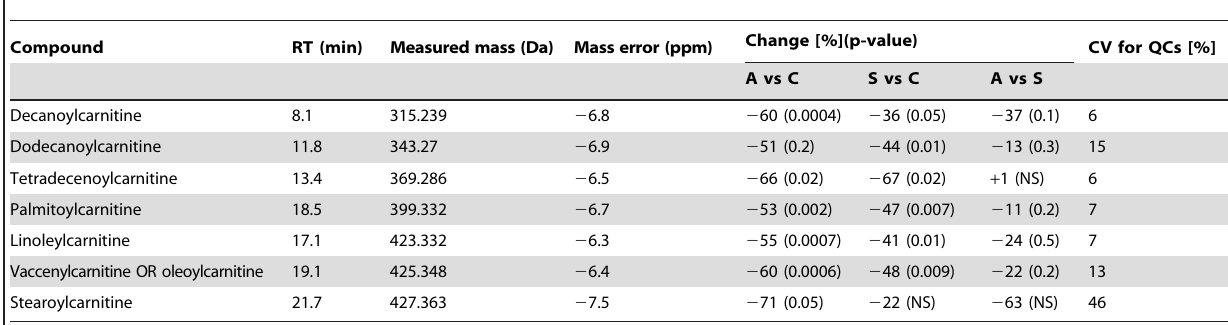
Table 3. Identification of acylcarnitines that were significantly differentiating plasma profiles of AAA patients from controls.